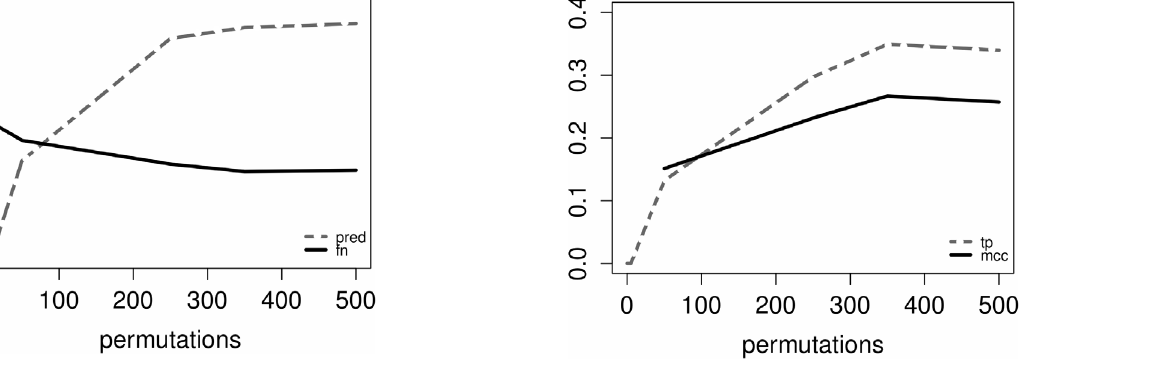
Figure 4. True positives and Matthew Correlation Coefficient vs. number of permutations.